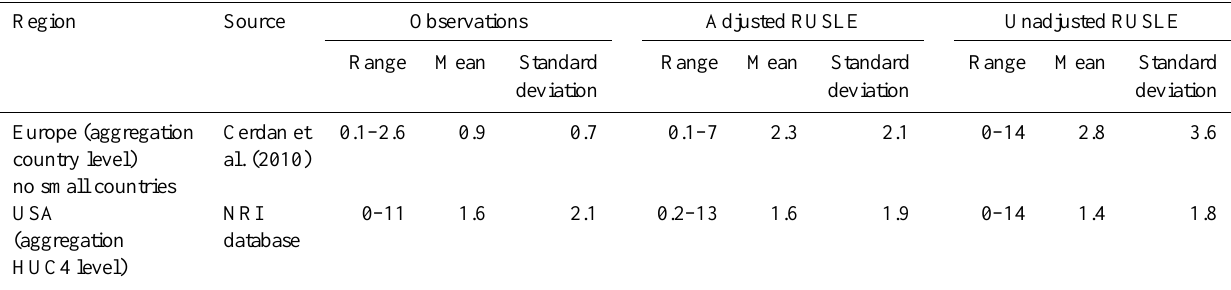
Table 9. Statistics of the observed and modelled erosion rates from the unadjusted and adjusted versions of the RUSLE for the USA and Europe (tha − 1 year − 1